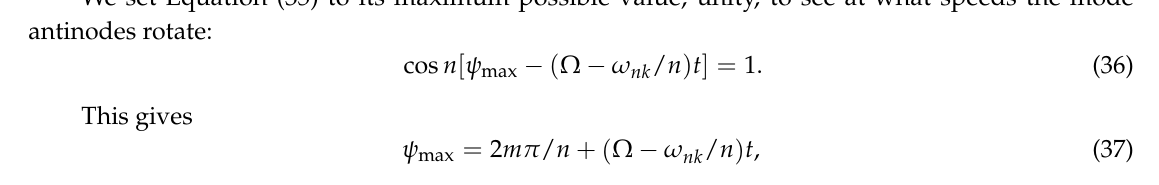
(cid:112) ε V 2 / ρ hg 3 / ω fn .